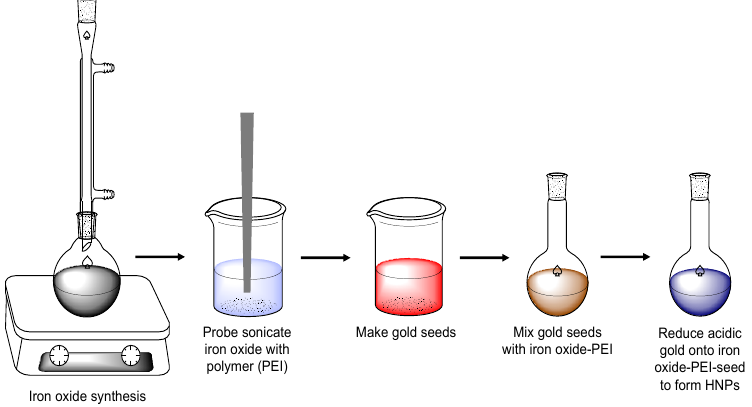
Figure 1. Current benchtop synthesis route to form core-shell gold-coated iron oxide hybrid nano- particles.